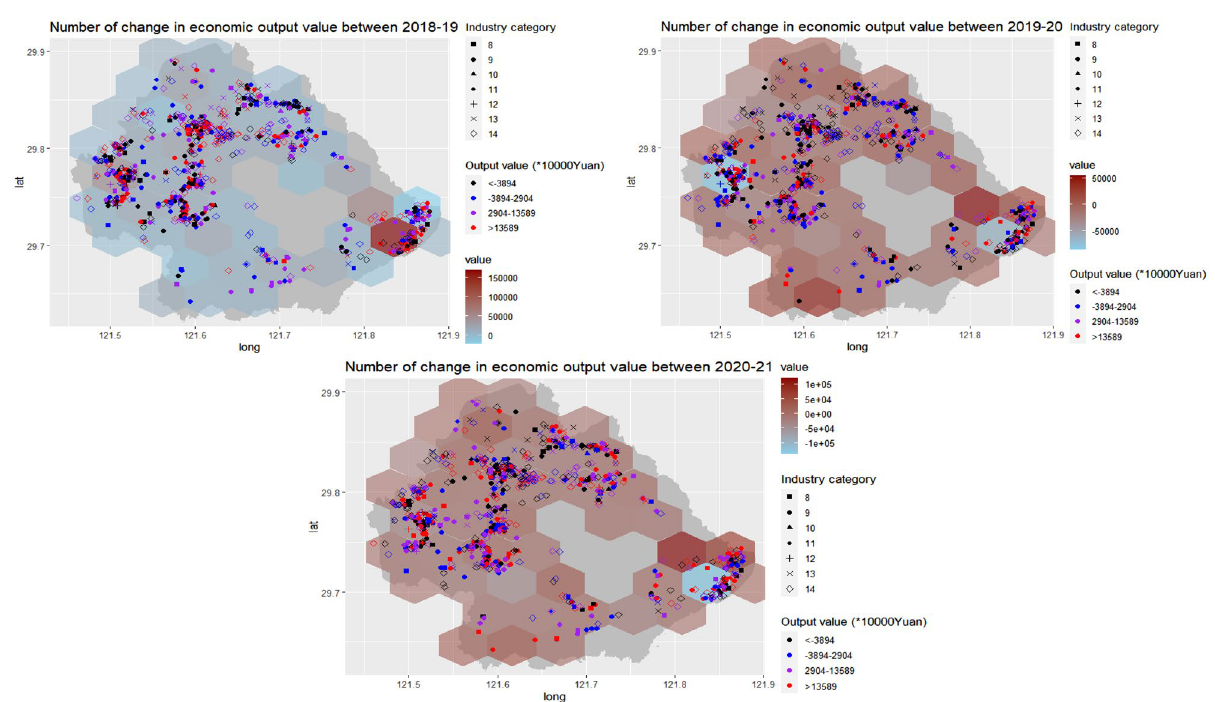
Figure 2. The distribution of economic output value dynamics in Yinzhou from 2018 to 2021 by space and time. (Industry category: 8 (motorcar), 9 (high-level equipment), 10 (new materials), 11 (intelligent home electrics), 12 (key fundamental part), 13 (fashion and clothes), 14 (new service and